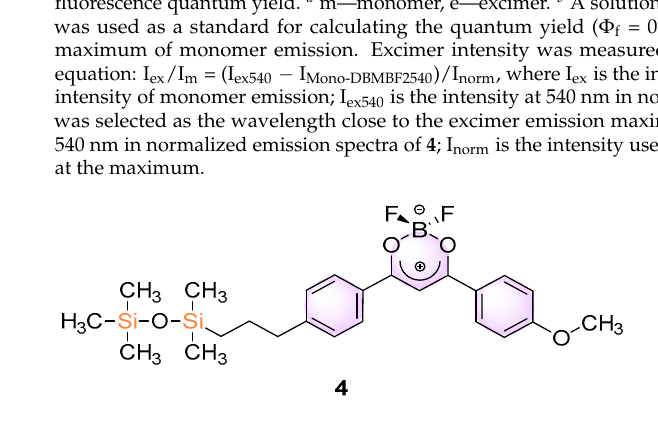
Figure 20. Schematic representation of the physical network formation in polymers 3 a,b after heat- ing to 120 °C.